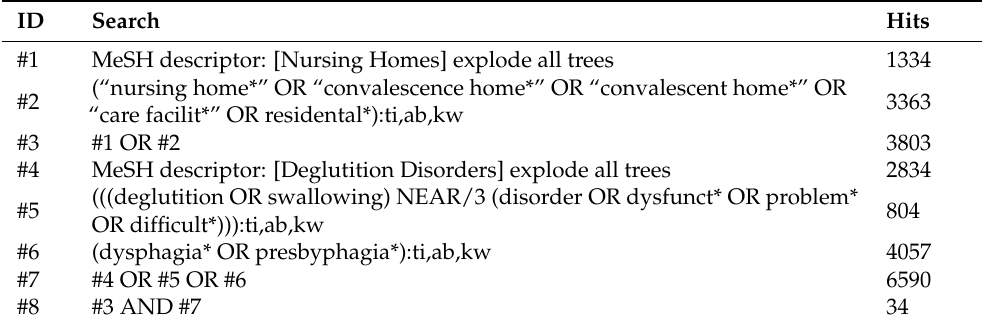
Table A2. Cochrane